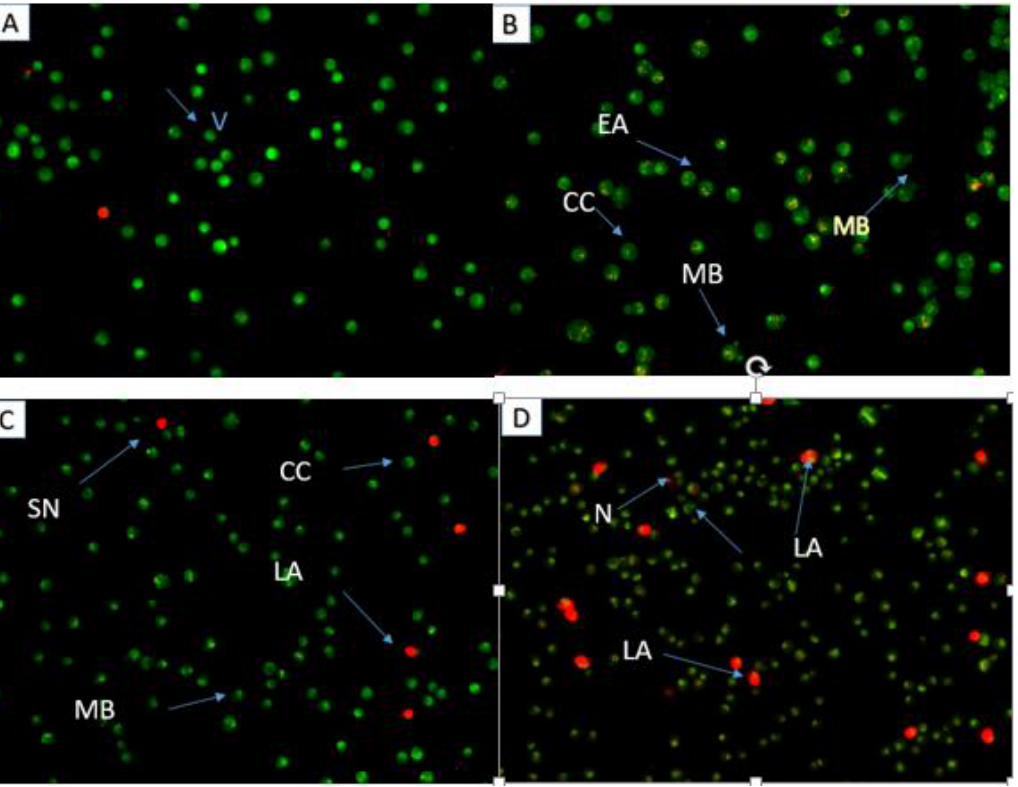
Figure 17. Fluorescent micrograph of MDA-MB-231 cells via (AO/PI). Untreated cells ( A ), treated cells 24 h ( B ), 48 h ( C ), and 72 h ( D ). Viable cells (V), early apoptosis (EA), chromatin condensation (CC), membrane blebbing (MB), late apoptosis (LA), necrosis (N).